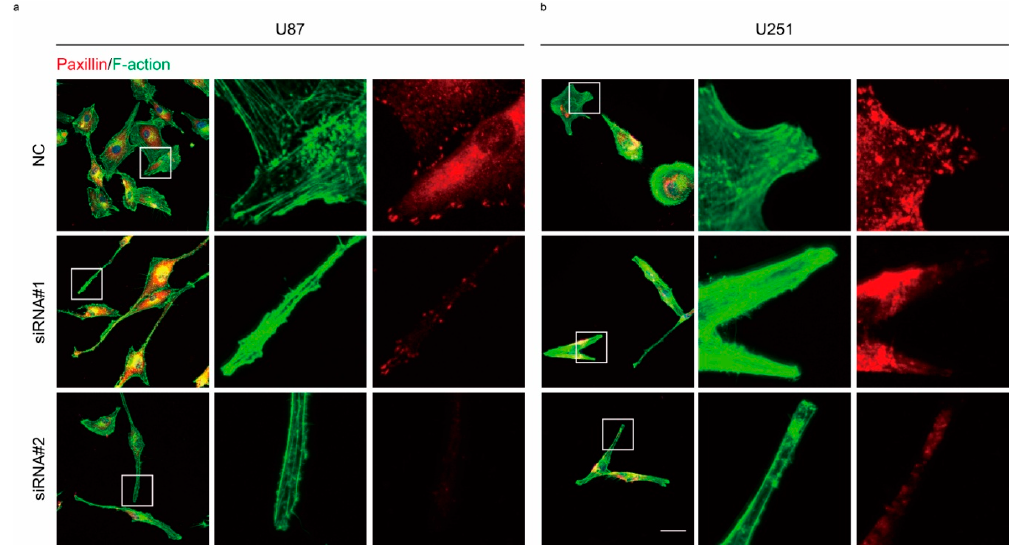
Figure 4. Rac1 is involved in cell adhesion formation. ( a,b ) Confocal sections of U87 and U251 cells depleted of Rac1 48 h post-transfection and stained for phalloidin (green) and Paxillin (red). Scale bar: 50 μ m.